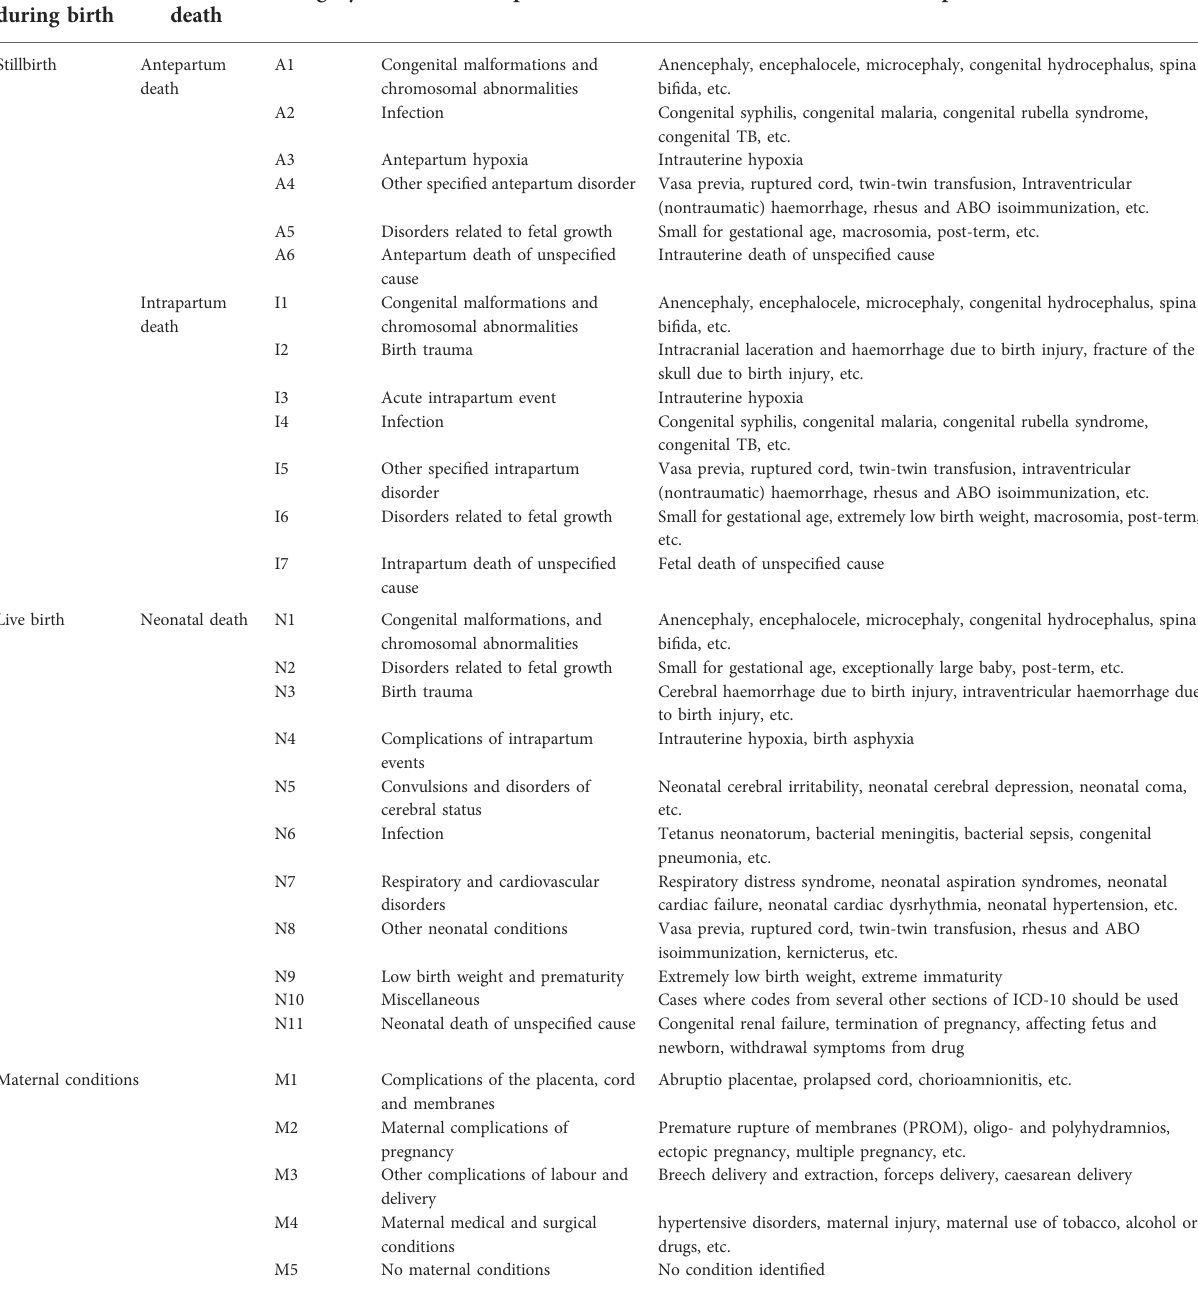
TABLE 1 ICD-PM categories with the speci fi c cause of perinatal death and maternal health